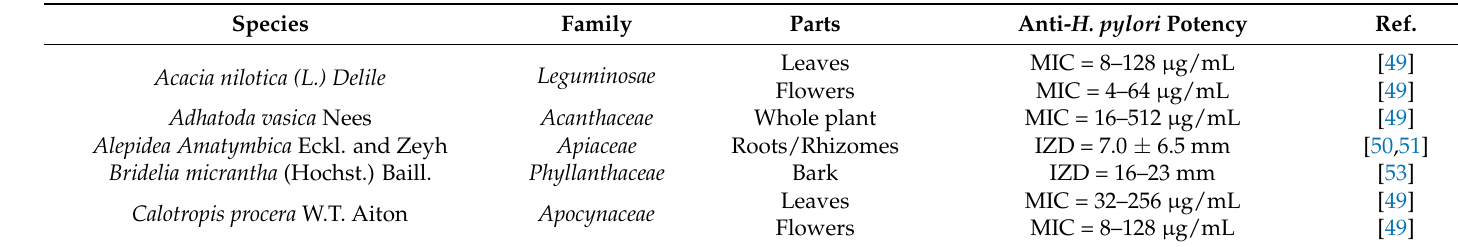
Table 5. Plant acetone extracts with anti- H. pylori